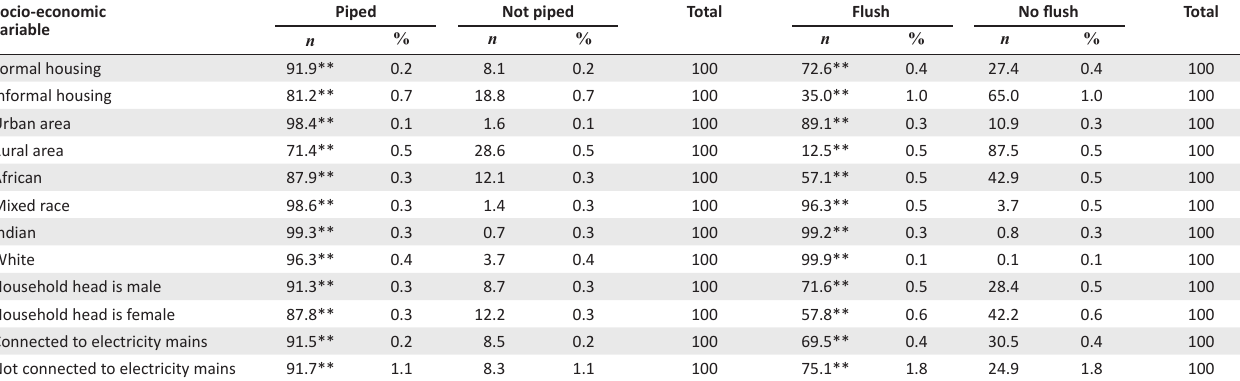
TABLE 2: Household socio-economic indicators. Socio-economic